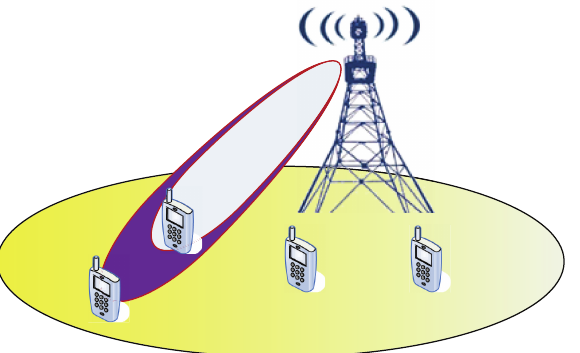
Figure 5: 3D dynamic beamforming in horizontal sight.